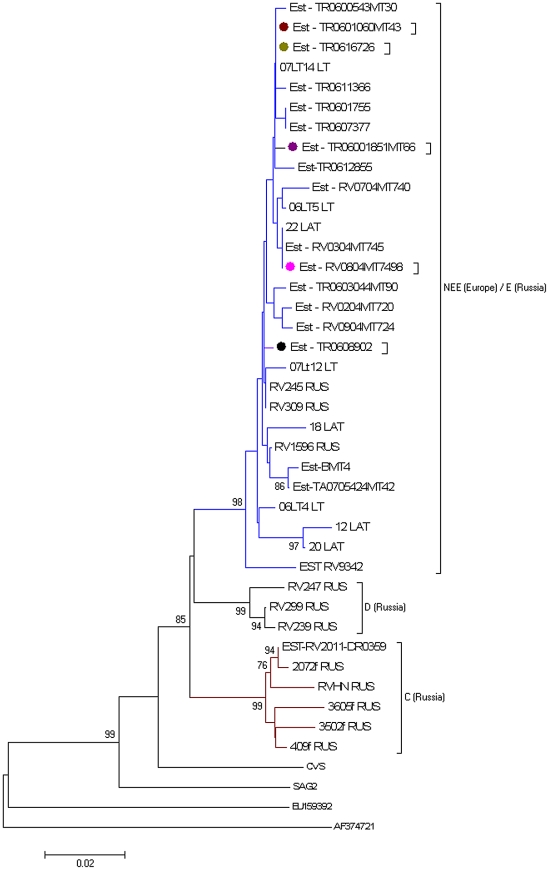
Neighbour Joining phylogenetic tree between 18 Estonian rabies virus sequences and 24 references isolates.The tree is rooted with isolates EU159392 and AF374721, used as outgroup. The phylogenetic analysis was based on the analysis of the first 400 nt of N gene using NJ method. Bootstrap values greater than 70% are shown next to the branches. Abbreviations for the phylogenetic groups (NEE, C, D and E) earlier described by Bourhy et al. [20] and Kuzmin et al. [21] are used in the text. In ◊ are shown the representative sequences of identical nucleoprotein sequences among rabies virus isolates from Estonia.